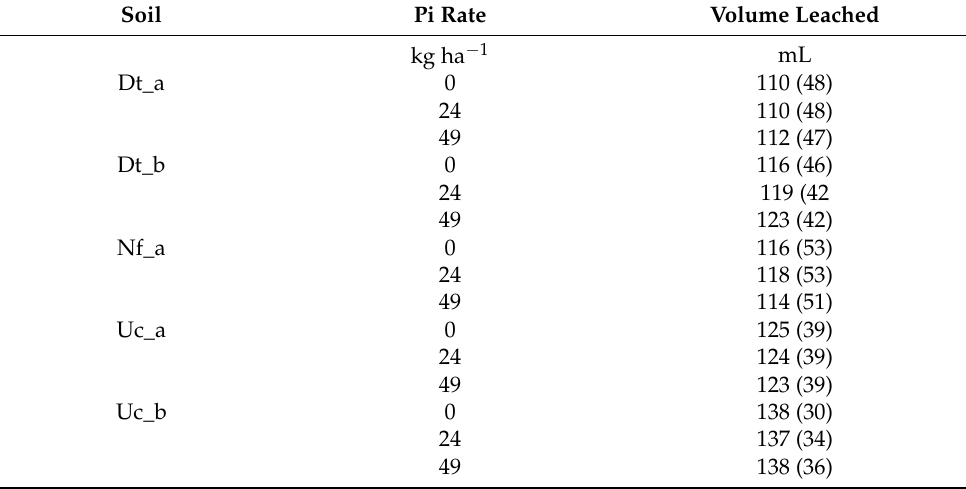
Table A1. Mean volume and (standard deviation) of two combined leachates recovered for each soil (n = 6) at three application rates of phosphite